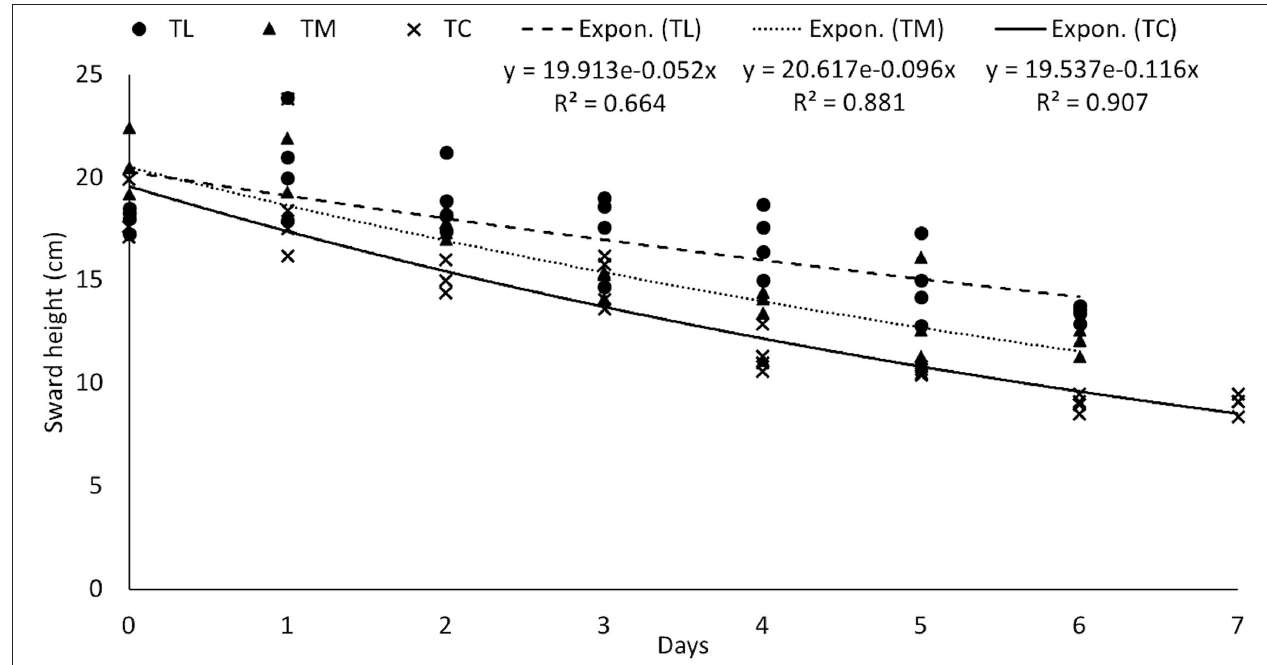
FIGURE 1 | Depletion dynamics of height throughout the grazing down by cows to post-grazing sward heights of 9 (TC), 12 (TM), or 15cm (TL). Fitted exponential equations for each treatment are shown within the figures under the series identification.